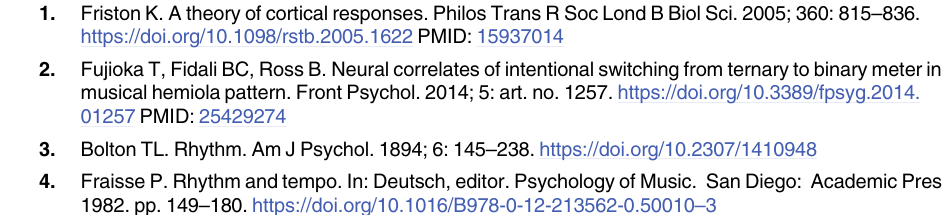
Fig I. Examples of Subdivision Grouping and Tapping Responses in a 2:3 Polyrhythm; Fig II. Data Cleaning and Circular Analyses to Categorize the Tapping Responses; Fig III. Tapping Data Overview; Fig IV. Tempo Control Trials with 120 BPM; Fig V. Tempo Control Trials at Faster Tempi; Fig VI. Pitch Control